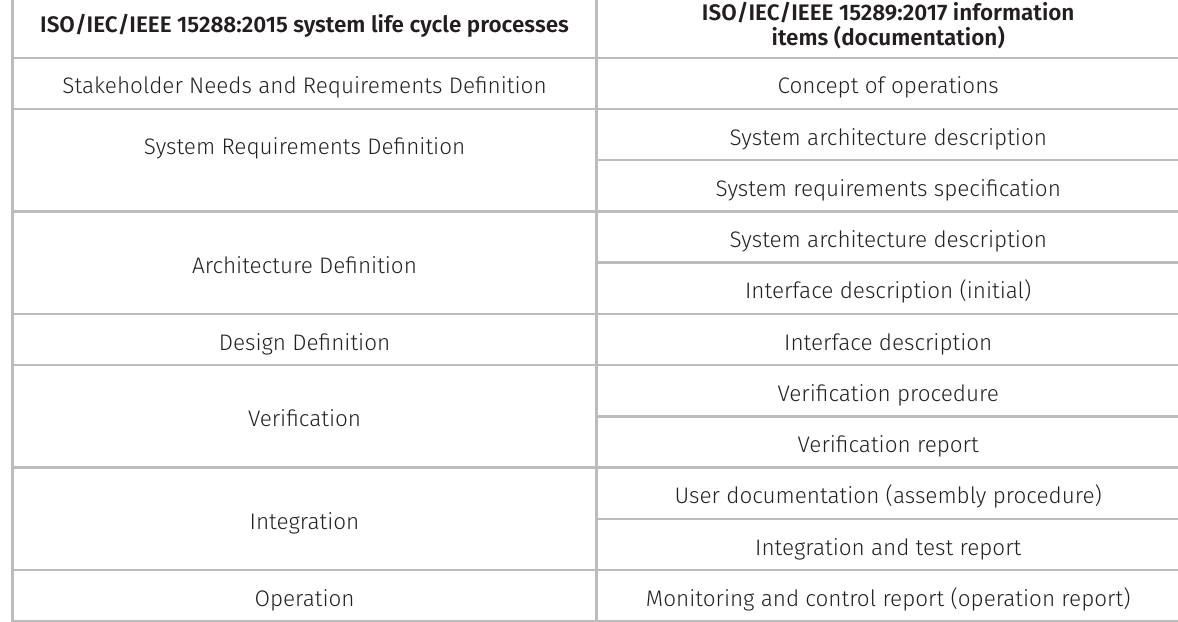
Table III. Information items selected for each system life cycle process. ISO/IEC/IEEE 15288:2015 system life cycle processes Stakeholder Needs and Requirements